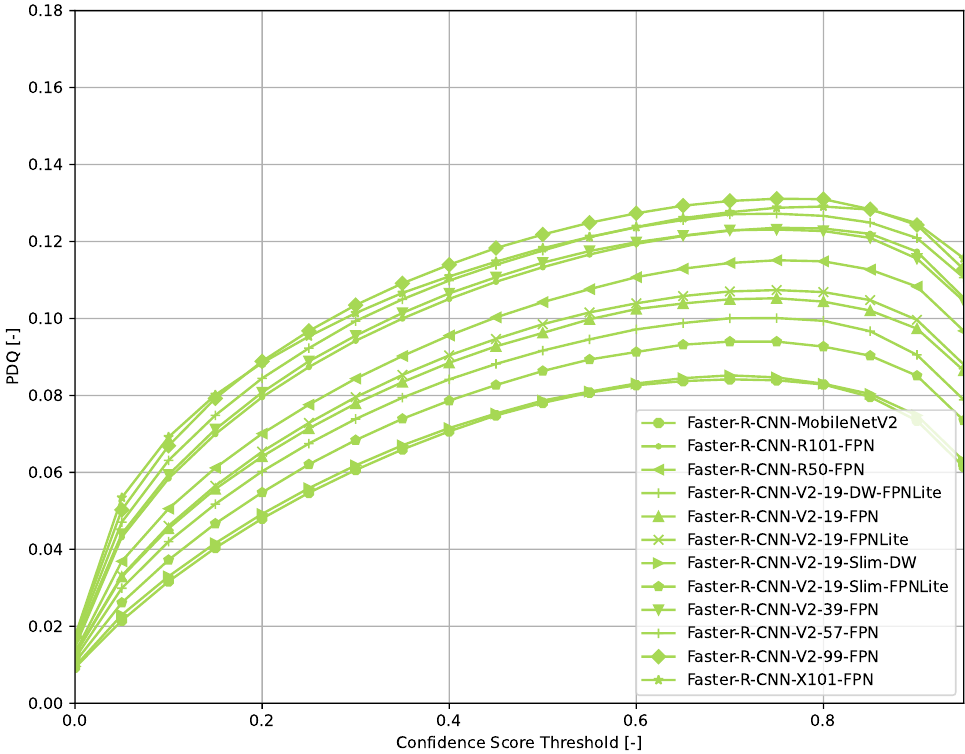
Figure 9. PDQ results of Faster R-CNN on the COCO